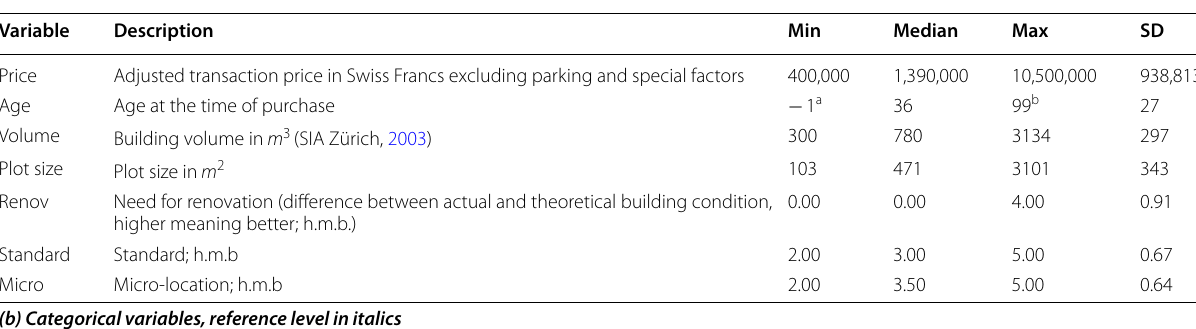
Table 2 Description and summary statistics of underlying data